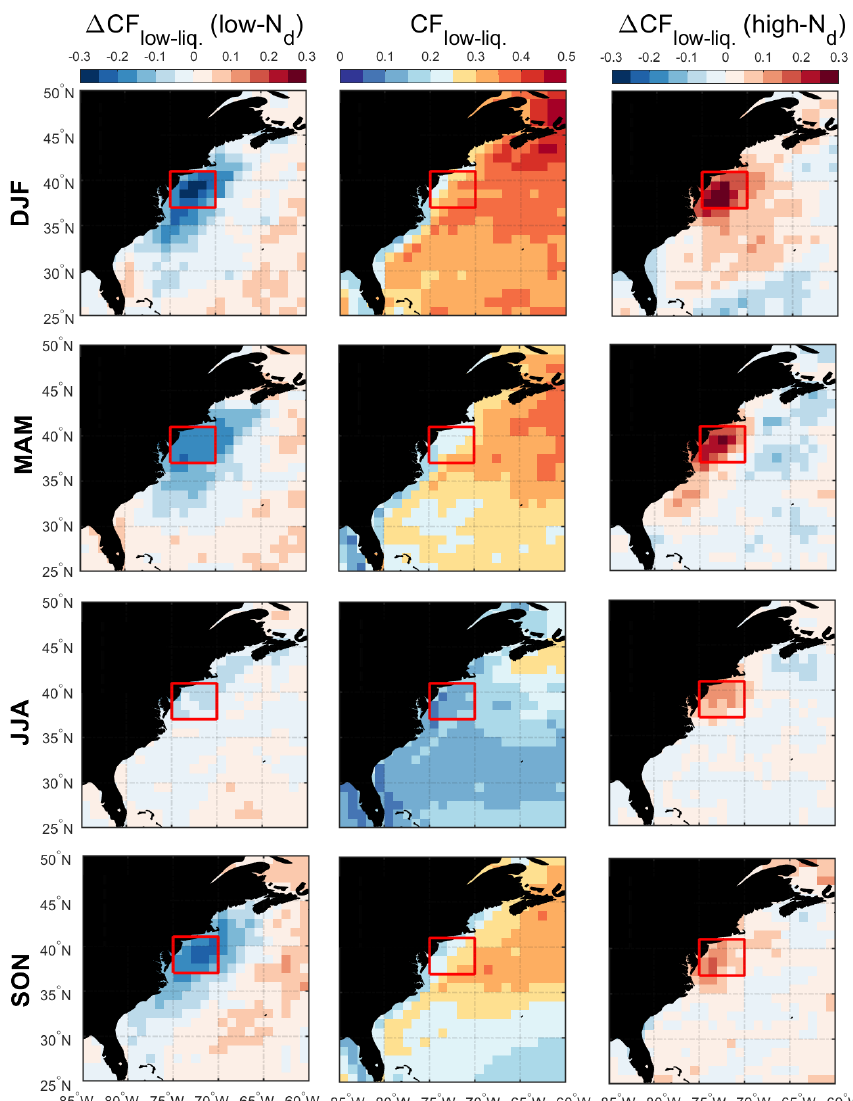
Figure 10. Seasonal averages of low-level liquid cloud fraction (middle column) and associated anomalies on low- N d days (left column) and high- N d days (right column). The red box represents sub-domain C-N for which the analysis was